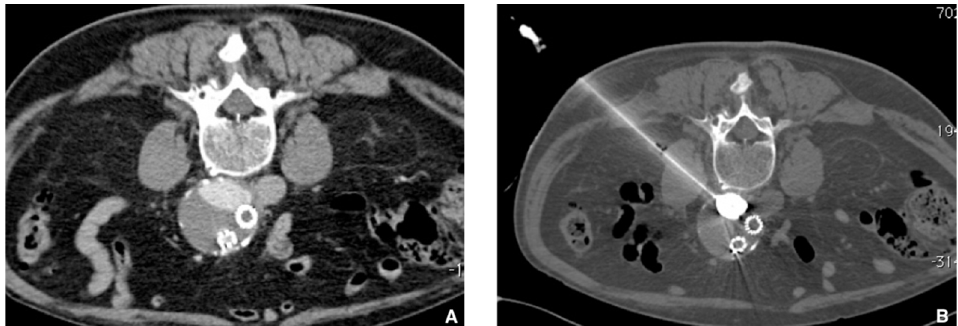
Figure 9. Type 2 endoleak from lumbar ateries. ( A ) Computer tomography (CT) scan with contrast injection in procubitus position showing posterior opacification of the periprothetic aneusrysmal sac (nidus). ( B ) Translumbar puncture of the nidus of the endoleak under CT guidance with a metallic needle. Insertion of a microcatheter inside and embolization of the nidus with a Glubran ® 2/lipiodol mixture (1:4 ratio) until complete nidus opacification.